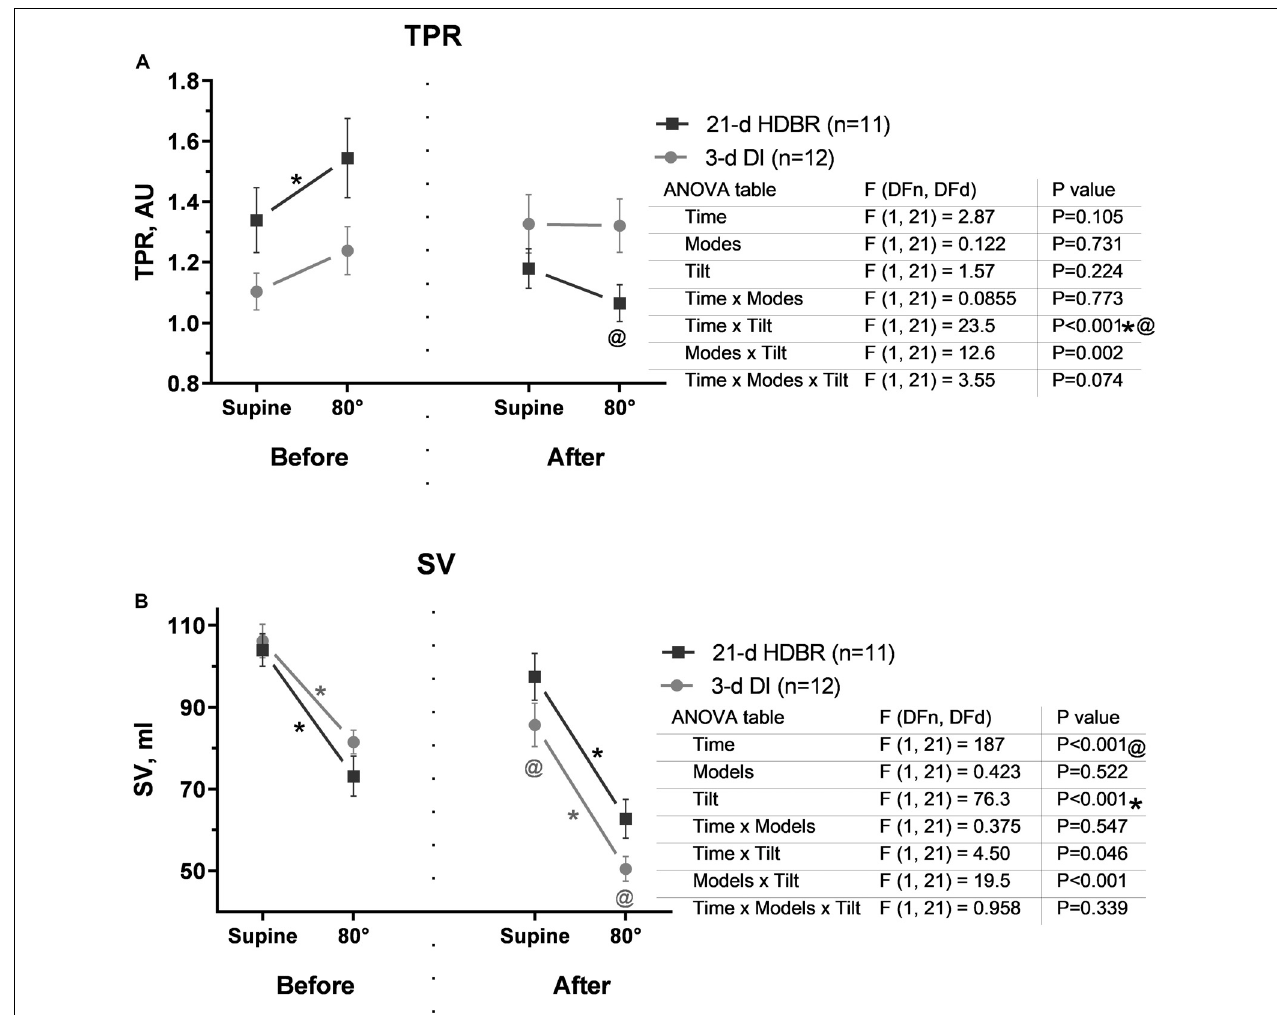
FIGURE 5 | Changes in total peripheral resistance (A) and stroke volume (B) in response to the 80 ◦ tilt test before and after the 21-day head-down bed rest (HDBR) and 3-day dry immersion (DI). Data are the mean ± SEM. # p < 0.05 between groups; * p < 0.05, 80 ◦ vs. the supine position; @ p < 0.05, before vs. after